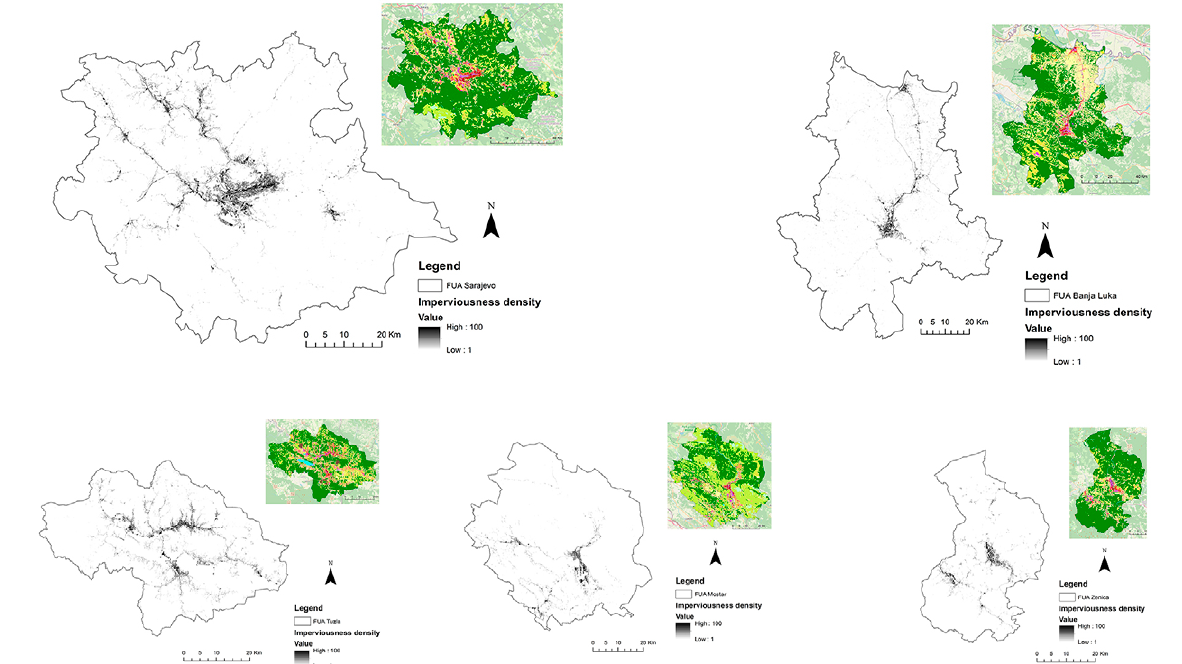
Figure4 to 8. Degree of Imperviousness and UA maps of the FUAs (the forest is shown in green, the agricultural land in yellow, and the urban areas in red) [click on figure to enlarge] Table 3. IMD 2018 and IBU 2018 total areasfor FUAs Sarajevo